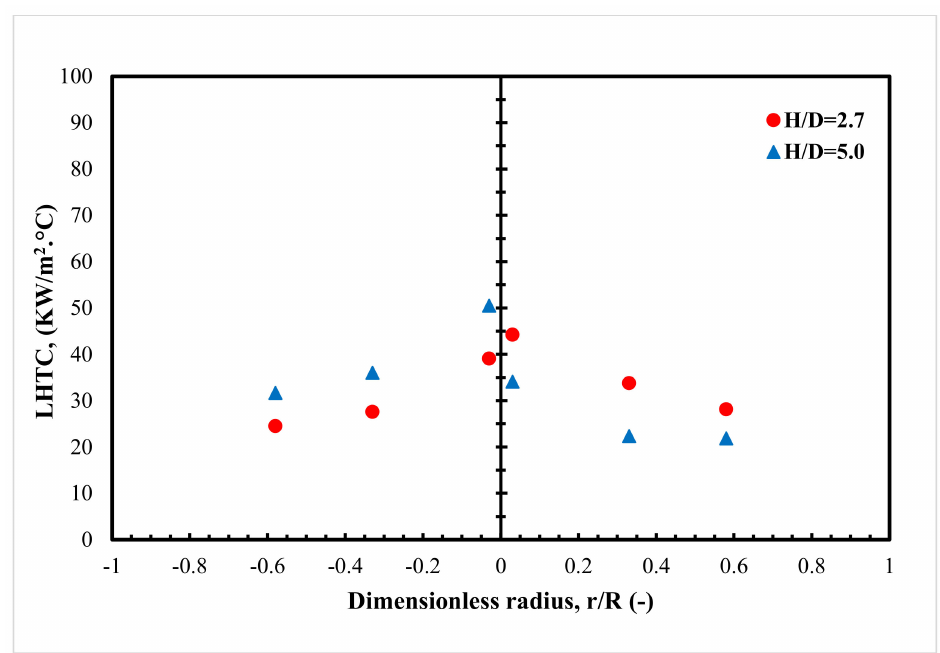
Figure 16. LHTC profiles measured at the different axial levels of 35 and 70 cm and under an operating gas velocity of 0.45